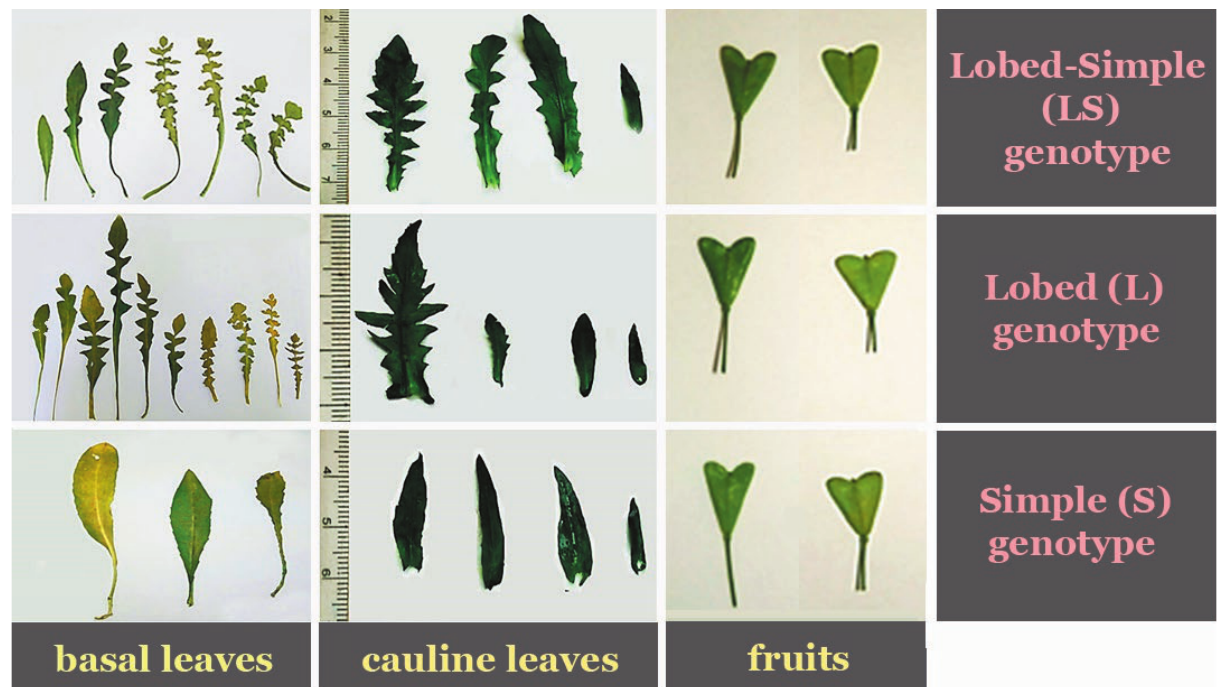
Figure 1. Morphological diversity within the Egyptian C. bursa pastoris genotypes; L: Lobed, S: Simple, LS: